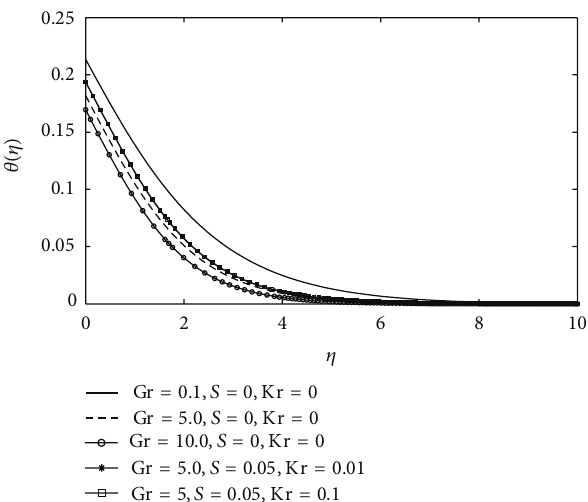
Figure 9: Temperature profiles for different values of Bi, 𝑆 , and Kr for Ha = 0.1 , Gr = 0.1 , Gc = 0.1 , Sc = 0.62 , Nc = 0.01 , and Pr = 0.72 .